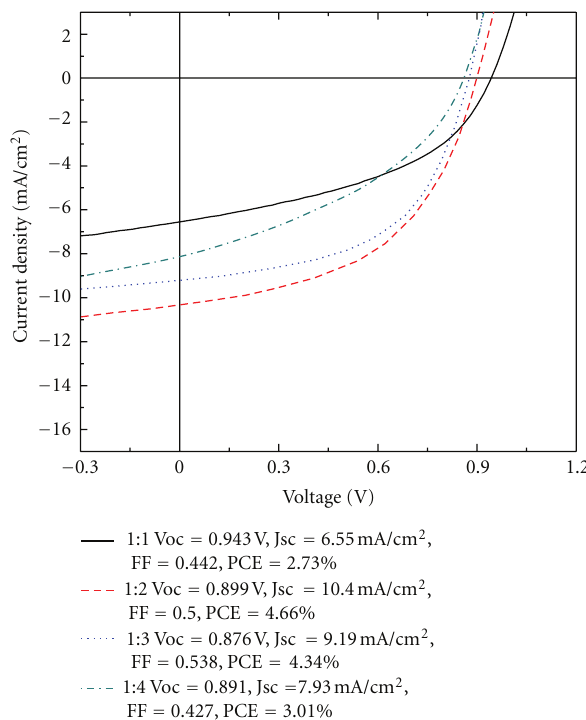
Figure 4: JV characteristics under 100 mW/cm 2 illumination by standard A.M. 1.5 solar simulator with P1:PCBM ratio at 1:1 (black solid), 1 :2 (red dash), 1: 3 (blue dot), and 1:4 (green dash-